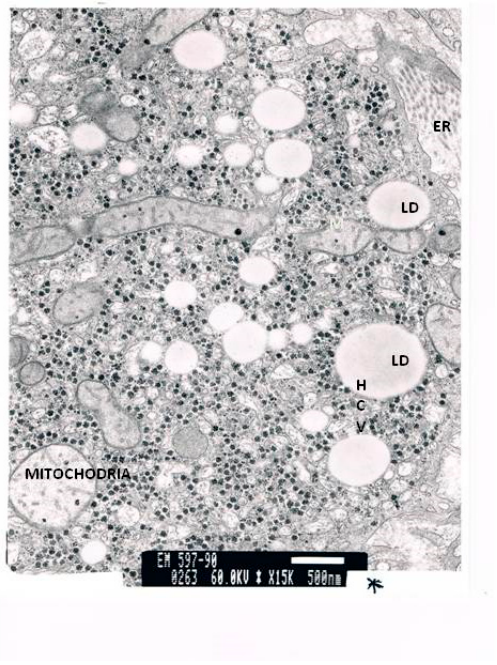
Figure 3. TEM of a liver biopsy. Many giant lipid vesicles and large confluent lipid droplets can be observed. There are many enlarged mitochondria with scattered unregular cristae. HCV antigen can be observed. HCV antibodies are present.